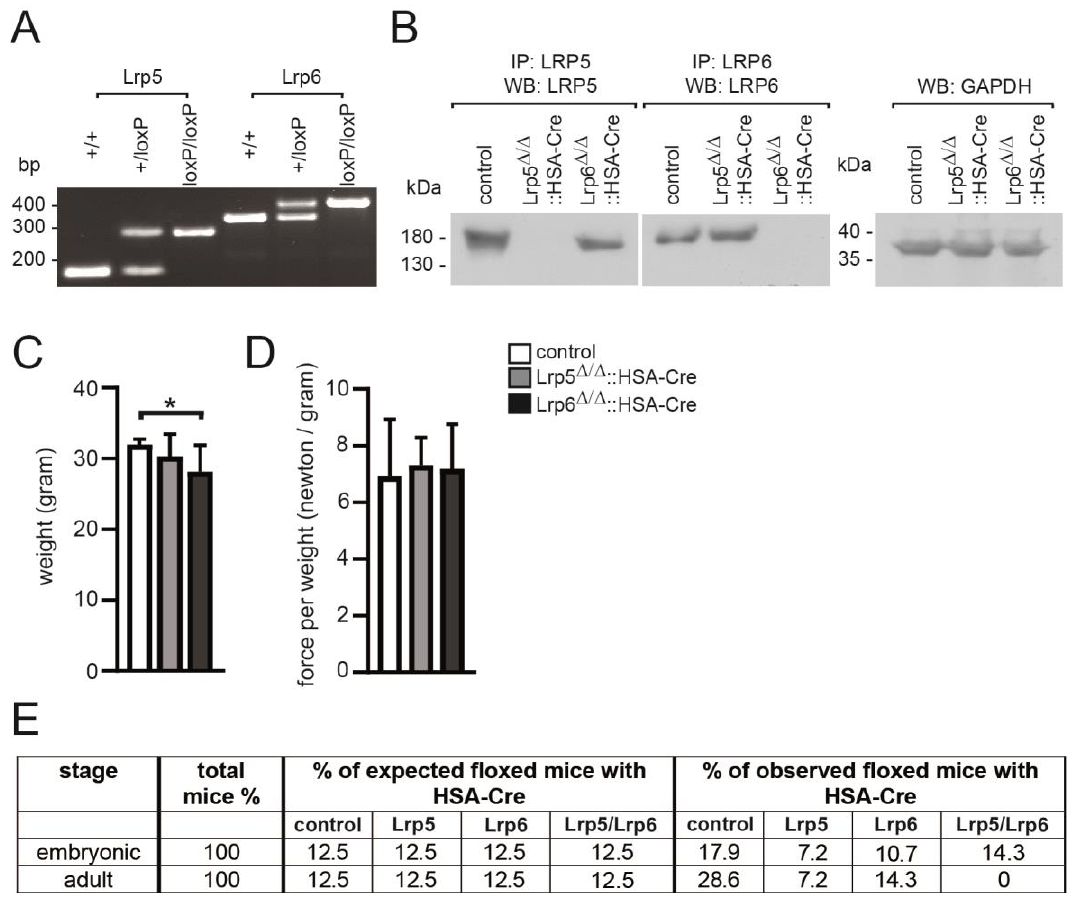
Figure 1. Phenotype of conditional Lrp5, Lrp6, and double knockout mice. ( A ) Agarosegel image of PCR genotyping demonstrates the heterozygous and homozygous floxed alleles of Lrp5 and Lrp6. ( B ) Images of X-ray exposure of Western blot membrane of muscle lysates (GAPDH) or immunoprecipitations of Lrp5 or Lrp6 using muscle hind limb lysates of control and mutant mice as indicated. ( C ) The graph reflects the body weight of control and single knockout mice at adulthood (4 – 7 months of age). Note that in comparison with controls, body weight of conditional Lrp6 knockouts is slightly reduced ( n = 8 – 16 mice per genotype). ( D ) Muscle force is presented by a graph summarizing force per weight for control and conditional single knockout mice. ( E ) Distribution of offspring of conditional Lrp5 and Lrp6 knockout mice ( n = 8 – 16 mice per genotype). Note that while conditional single knockout mice are born in agreement with mendelian distribution, double knockout die at embryonic stage. All labeling of graph bars represents genotype of mice as indicated in ( D ). * p <0.05.